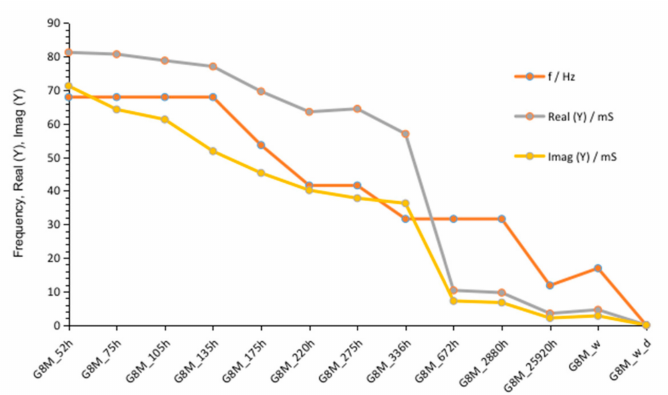
Figure 6. Changes of susceptance maximum and corresponding values: admittance and frequencies, depending on time passed from polymerization beginning; after removing conductive ions (G8M_w); after drying concrete